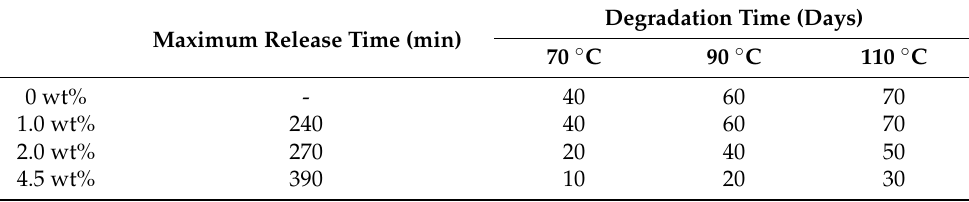
Figure 5. Accumulation of conductivity in the water release tests of bioplastics with different ZnO nanoparticle concentrations (1.0 wt%, 2.0 wt% and 4.5 wt%) processed at a mould temperature of 90 ◦ C. Table 1. Maximum release time of bioplastics with different ZnO nanoparticle concentrations (0 wt%, 1.0 wt%, 2.0 wt% and 4.5 wt%) processed at a mould temperature of 90 ◦ C and degradation time of bioplastics with different ZnO nanoparticle concentrations (0 wt%, 1.0 wt%, 2.0 wt% and 4.5 wt%) processed at different mould temperatures (70 ◦ C, 90 ◦ C and 110 ◦